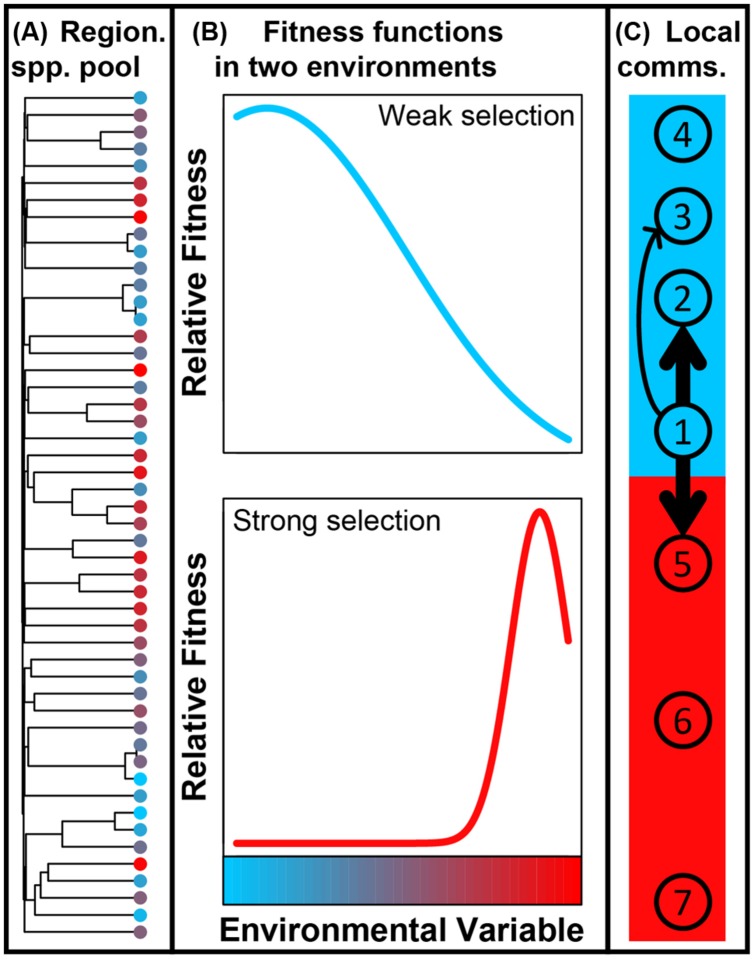
(A) Phylogeny showing evolutionary relationships among a subsample of 50 species from the regional species pool simulation model; colors indicate environmental optimum of each species along the arbitrary environmental gradient. (B) Fitness functions in two environments along the environmental gradient (see color ramp on bottom panel) that—for illustration—could be cold (blue) and hot (red). The ‘cold’ environment is characterized by relatively weak ecological selection; the blue Gaussian function describes how fitness declines as a species environmental optimum deviates from the blue environment’s temperature. The ‘hot’ environment is characterized by strong selection; fitness declines rapidly as species environmental optima move away from the red environment’s temperature, as indicated by the red Gaussian fitness function. (C) Assembly of all local communities was simulated by probabilistic dispersal (not diagrammed) from the regional pool; a species’ probability of dispersal and its local abundance increased with its fit to the local environment. Species abundances in communities 2, 3, and 5 were further influenced by dispersal from community 1; arrows indicate dispersal and thicker arrows indicate higher dispersal rates. Primary and secondary ecological processes governing turnover between pairs of communities—and the associated expectations for βNTI and RCbray—are summarized in Table 1.